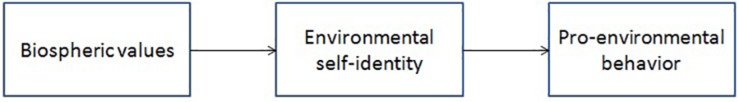
Theoretical model on the relationship between biospheric values, environmental self-identity and pro-environmental behavior (adapted from van der Werff et al., 2014b).